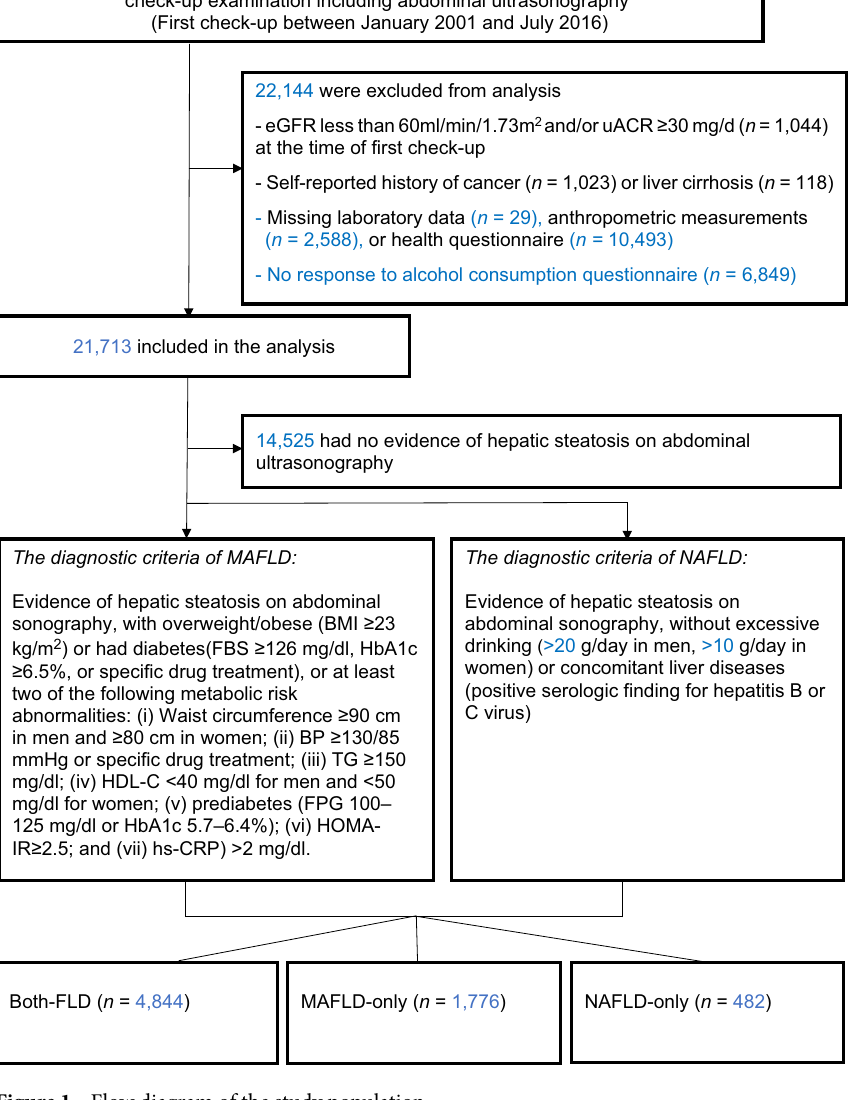
Figure 1. Flow diagram of the study